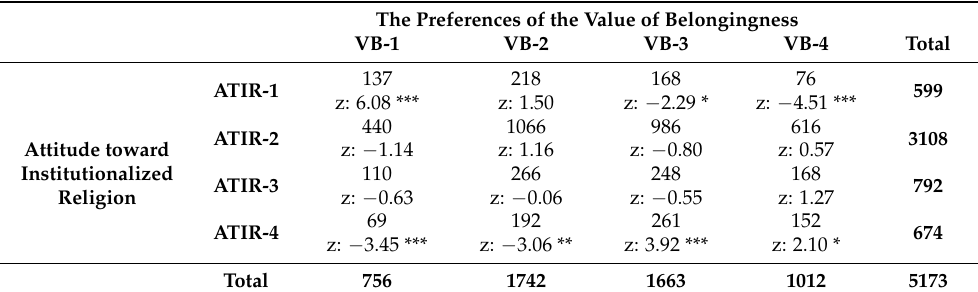
Table 2. Relationship between the preference for the value of belongingness (VB) and the attitude toward institutionalized religion (ATIR).